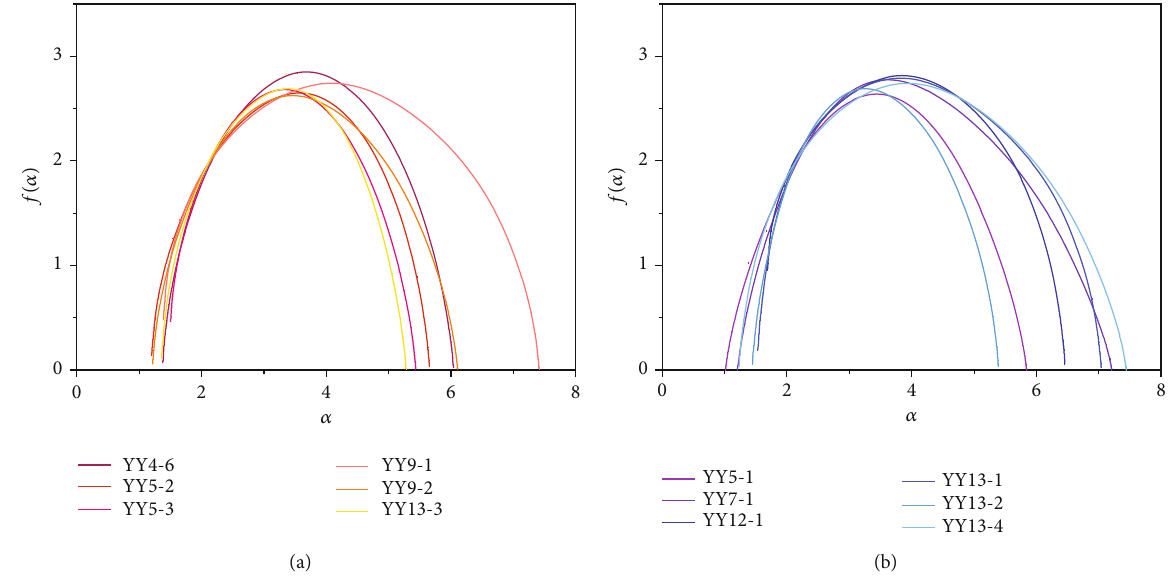
Figure 8: Multifractal spectra of Chang 7 shale pore structures obtained from nitrogen adsorption. (a) SM lithofacies. (b) MS lithofacies.